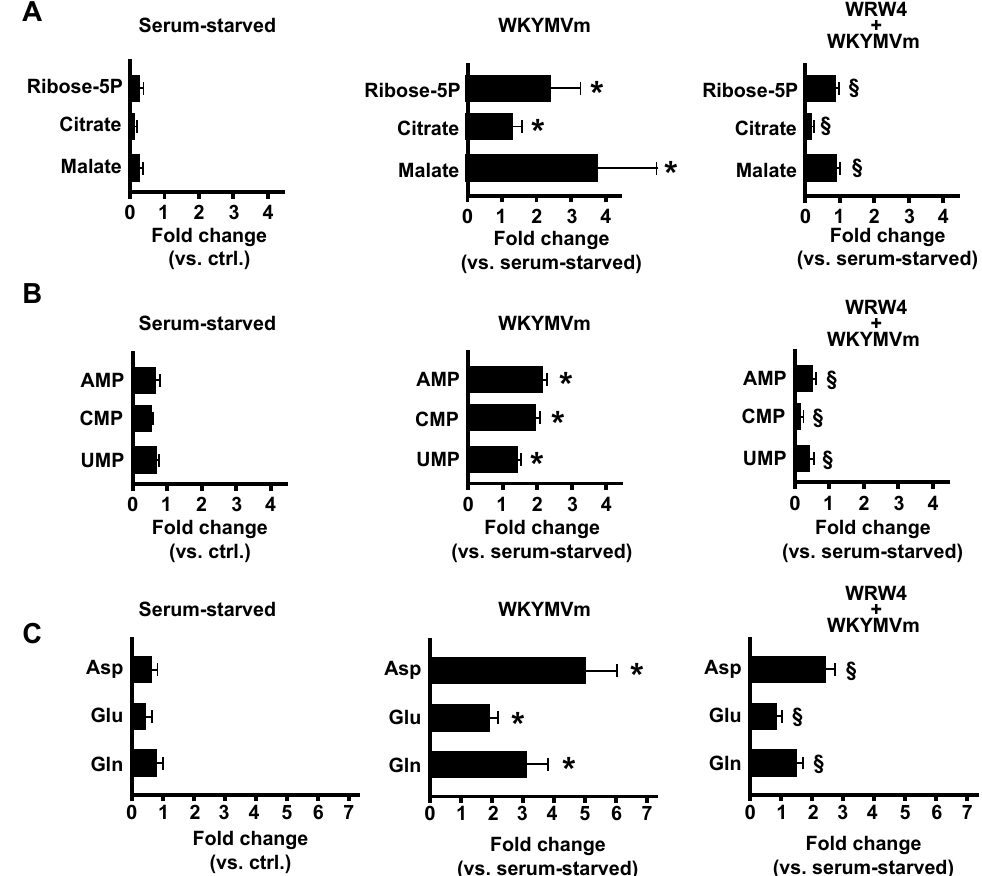
Figure 1. FPR2 stimulation modulates lung cancer cell metabolism. Growing cells (ctrl.) were serum-starved for 24 h and then stimulated or not with 10 µ M WKYMVm for 1 h in the presence or absence of 10 µ M WRWWWW (WRW4). The metabolomic analysis was performed as described in the Materials and Methods Section. The FPR2-dependent modulation of metabolites involved in glucose metabolism, nucleotide synthesis, and amino acid metabolism is reported in Panels ( A , B , C ), respectively. * p < 0.05 compared to unstimulated cells. § p < 0.05 compared to stimulated cells. Ribose-5P: ribose 5-phosphate; Asp: aspartate; Glu: glutamate; Gln: glutamine.